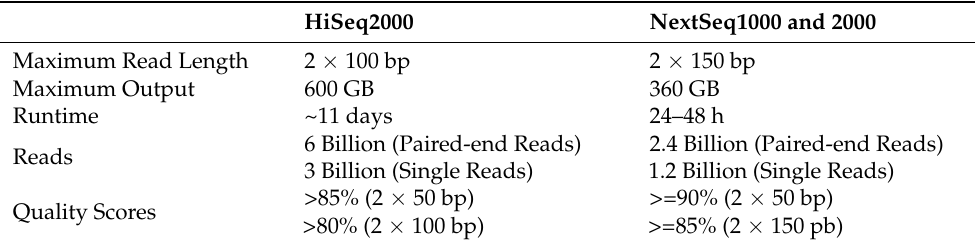
Table 2. The features of HiSeq and